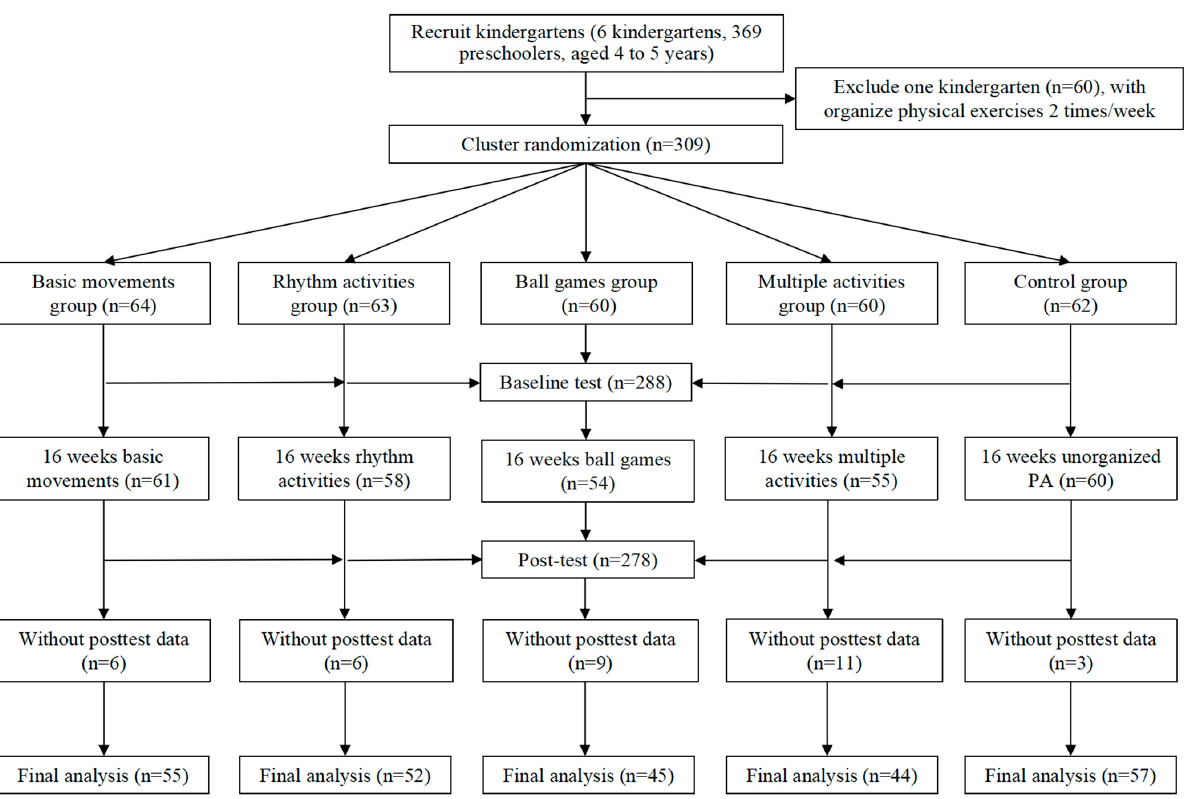
Figure 1. Flow chart of research